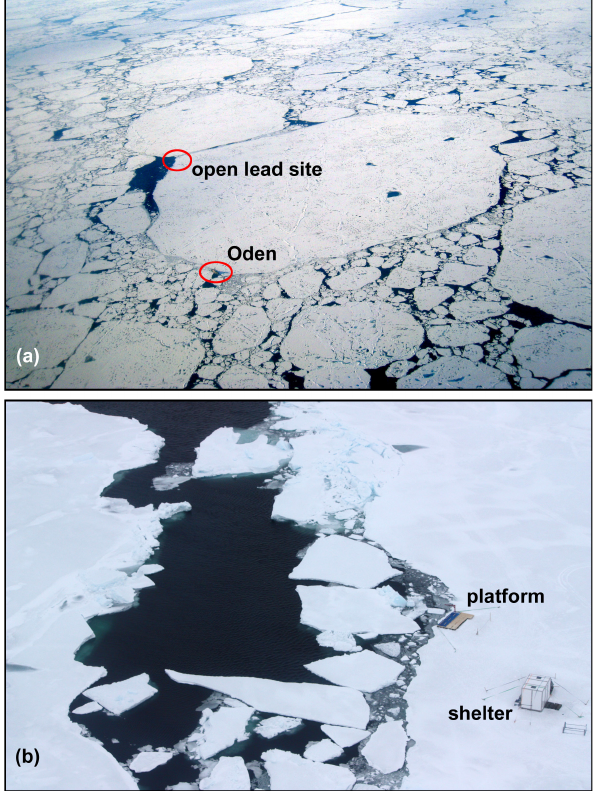
Fig. 2. (a) The ice floe on which the ASCOS measurements took place with the Oden and open lead sampling site ringed. (b) The open lead sampling site seen from the air on 14 August 2008 during a period when the wind had narrowed the lead and driven small sections of ice against the near side. The small shelter at bottom right housed the bubble camera data acquisition system and acted as an equipment store. The platform provided a secure location to take water samples from. The bubble camera was deployed close to the near side of the